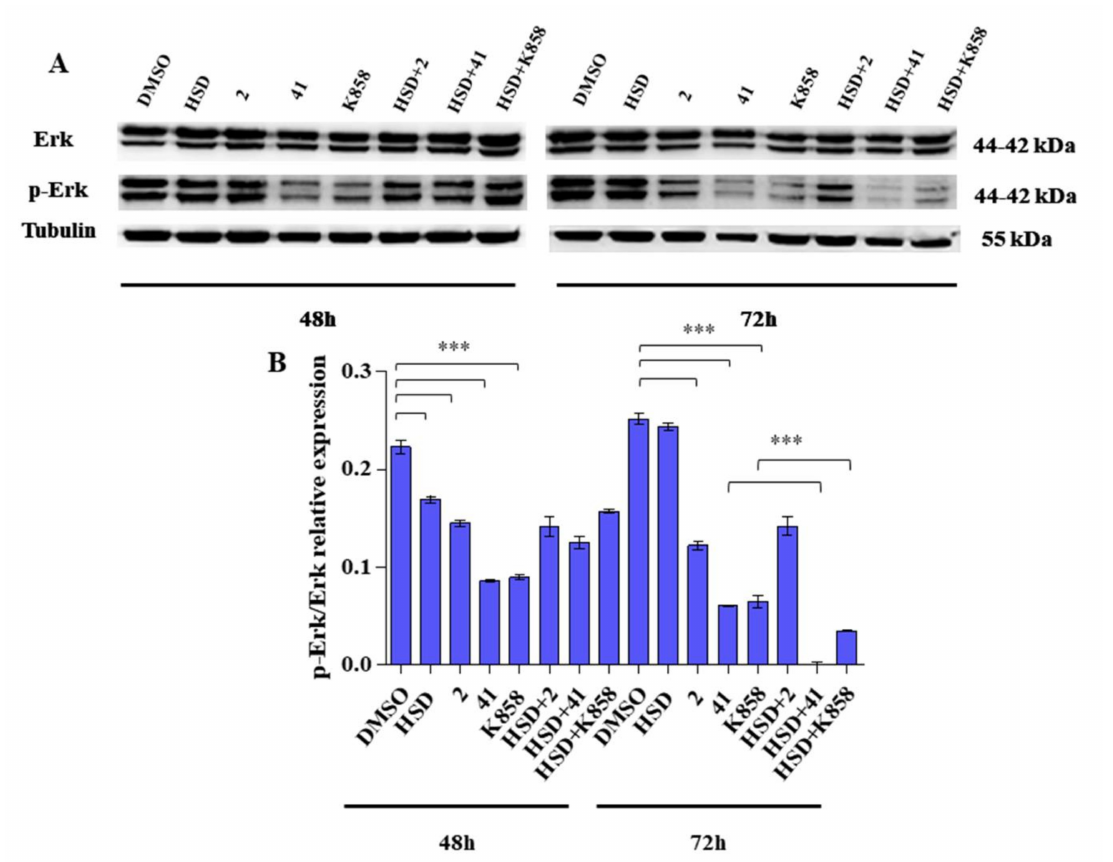
Figure 9. ( A ) Anti-p44/42 MAPK (Erk 1/2) and anti-phospho-p44/42 MAPK (p-Erk 1/2) expression levels in AGS cell line treated with HSD (180 µ M), 2 (1 µ M), 41 (5 µ M), K858 (1 µ M), and a combination of HSD with each Eg5 inhibitor for 48 and 72 h. DMSO 0.5%: control vehicle. Data are reported as means ± SD of three independent experiments. Tubulin is used as a loading control. ( B ) The bar graph displays densitometric values expressed as mean ± SD of p-Erk/Erk ratio normalized on loading control. *** p <